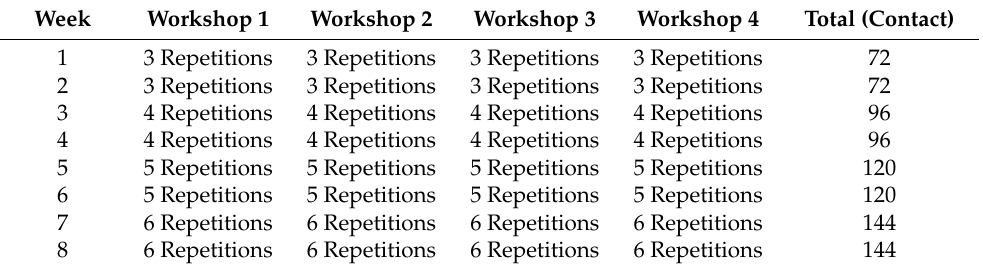
All repetitions and workshops were separated by 90 s recovery